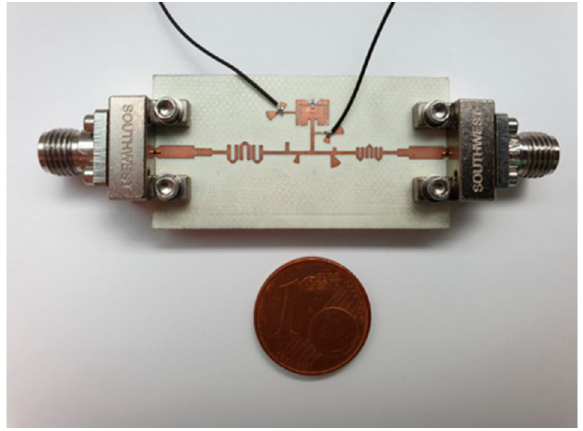
Figure 10. Photography of the fabricated filtenna prototype.